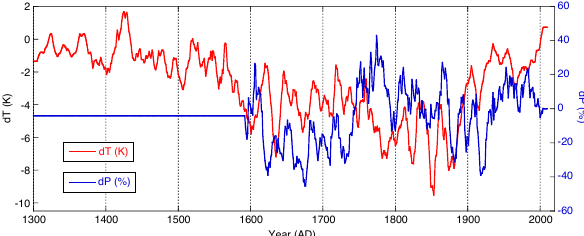
Fig. 7. Climate history used to simulate the evolution of Abrahamsenbreen during the late 2 Figure 7. Climate history used to simulate the evolution of Abra- Holocene (Van Pelt et al., 2013). Shown are anomalies of the annual mean temperature and 3 hamsenbreen during the late Holocene (Van Pelt et al., 2013). the annual precipitation. 4 Shown are anomalies of the annual mean temperature and the an- nual precipitation.